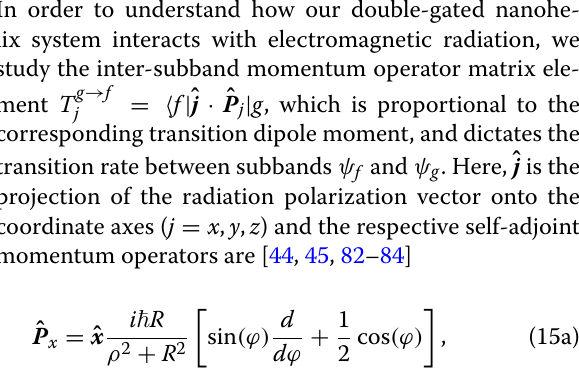
ized transverse to the helix axis couples coefficients with angular momentum differing by unity (cid:13) m = ± 1, whereas